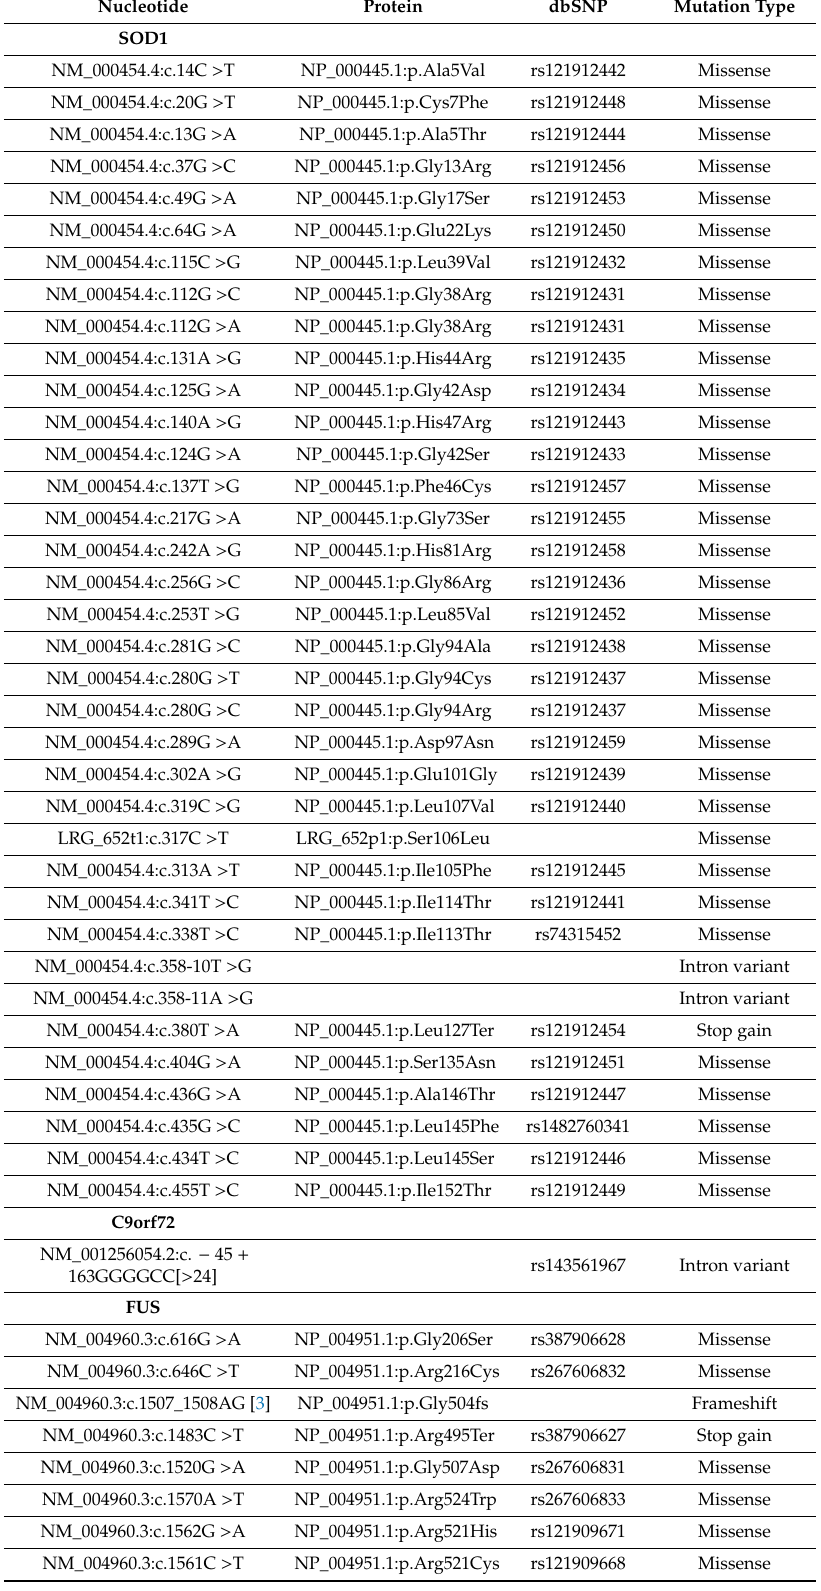
Table 1. Amyotrophic lateral sclerosis (ALS)-associated pathogenic variants in SOD1 , C9orf72, FUS, and TARDBP (Genome Aggregation Database (gnomAD)